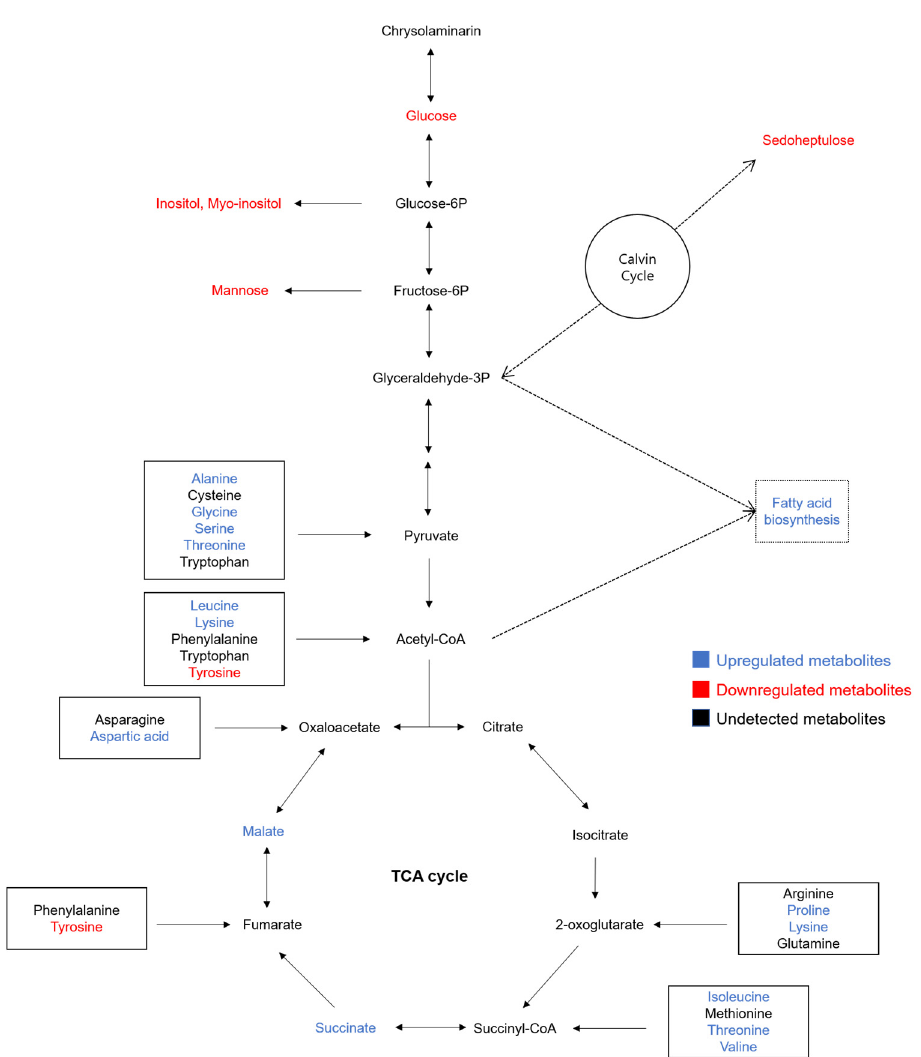
Figure 5. Metabolic changes in the P. tricornutum cells mapped onto metabolic pathways when grown on fermented okara culture compared to F/2 culture.